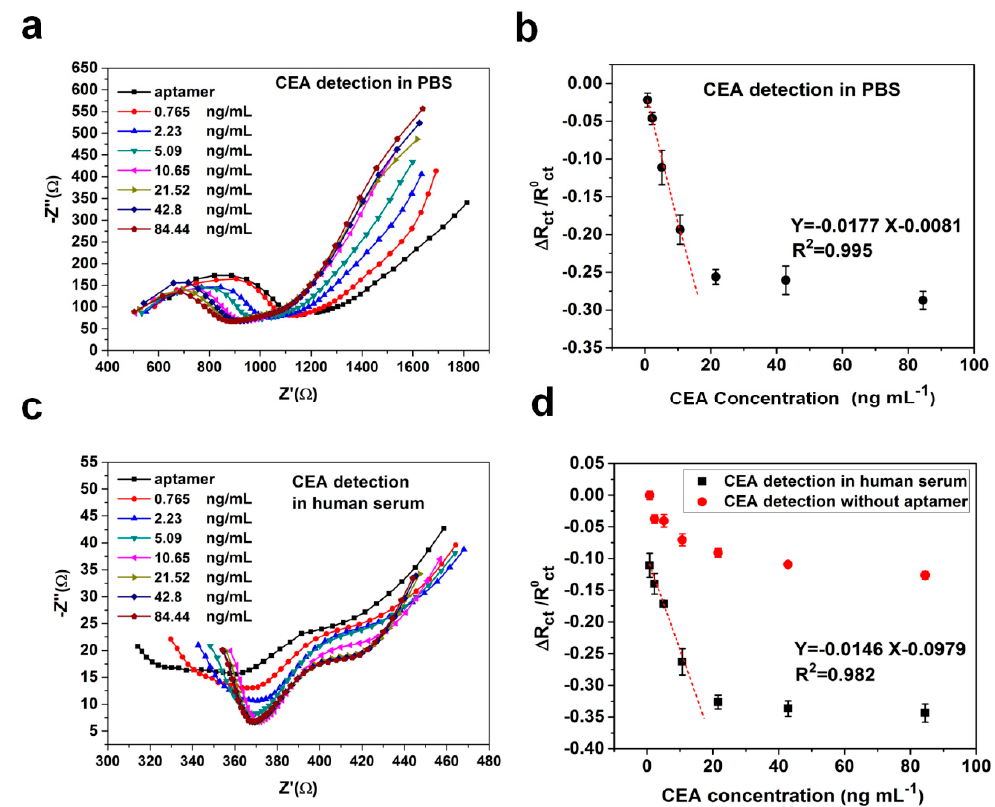
Figure 4. ( a ) Nyquist plot of EIS responses to different concentrations of carcinoembryonic antigens (CEA) in 0.1 M PBS solution (pH = 7.4); ( b ) The calibration curve between the relative change rate of R ct and concentration of CEA in PBS samples ( n = 5); ( c ) Nyquist plot of EIS responses to different concentrations of CEA in human serum samples; ( d ) The calibration curve between the relative change rate of R ct and concentration of CEA in human serum samples ( n = 5).